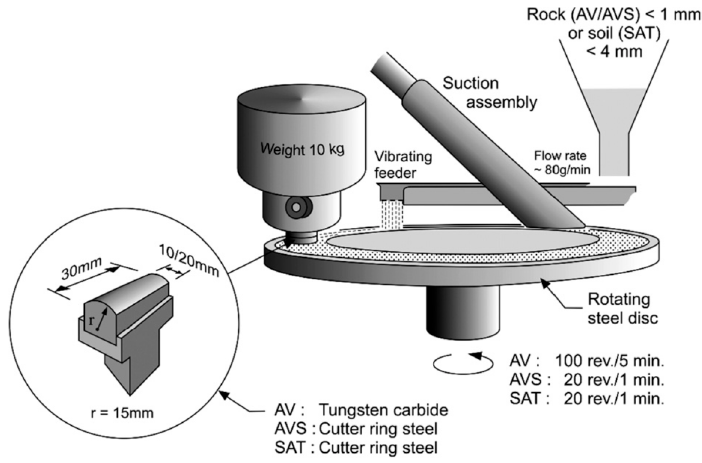
Figure 2. Outline of abrasion value (AV) and abrasion value cutter steel (AVS) [24].